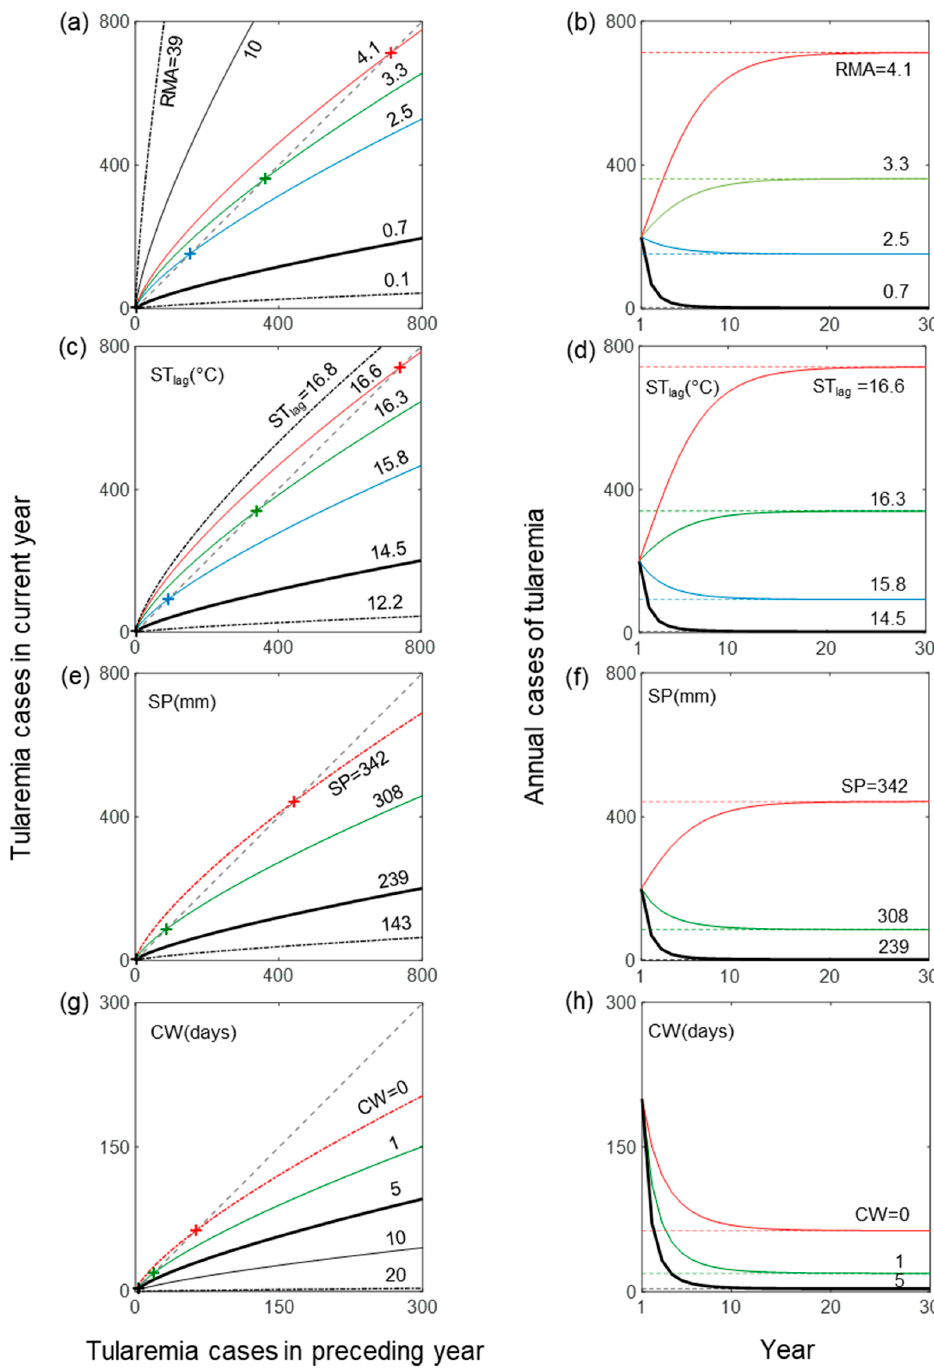
Figure 3. Resulting number of outbreaks and endemic level of tularemia for different hydroclimatic conditions in terms of ( a , b ) relative mosquito abundance (RMA) (hydroclimatically determined), ( c , d ) summer temperature in preceding year (ST lag ), ( e , f ) summer precipitation (SP), and ( g , h ) number of cold winter days with low snow coverage (CW). Panels on the left (right) show tularemia cases (solid colored lines) in current year as a function of cases in the preceding year (time), for different given values of the specific hydroclimate variable considered in each panel, and an initial number of 200 cases (all panels). Dot-dashed lines in the left-hand panels indicate results for observed minimum and maximum hydroclimatic variable values, while the bold line indicates the observed median variable value. The dashed lines in the right-hand panels show the resulting endemic levels (crosses in the left-hand panels).